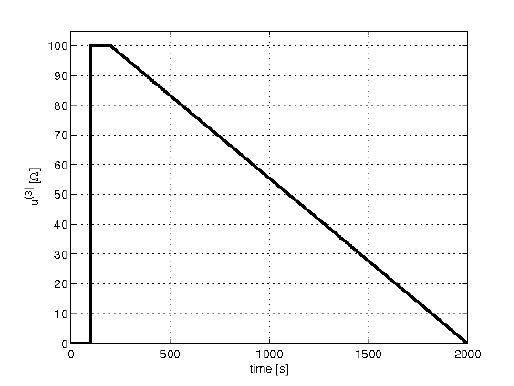
Figure 4. Input function u (3)